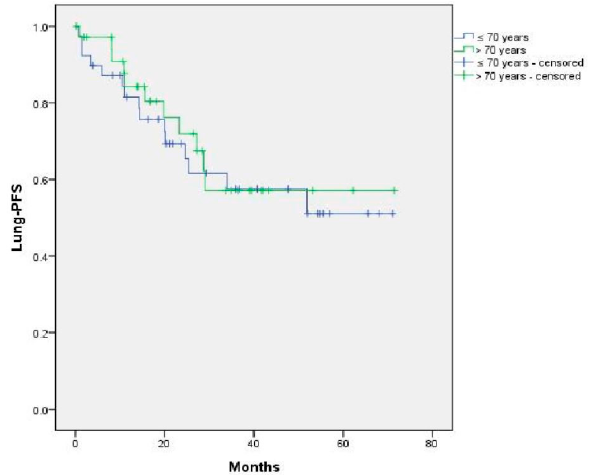
Figure A1. Impact of age on L-PFS. p = 0.73.